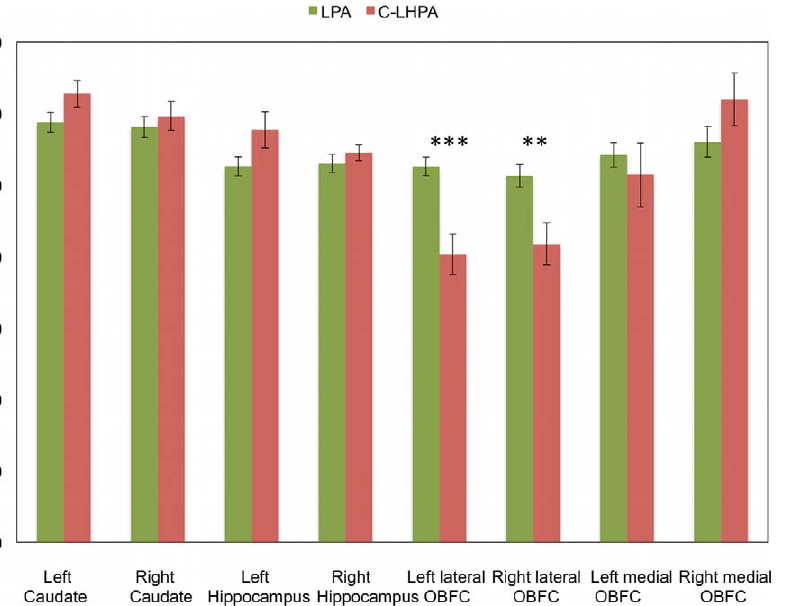
Figure 1. Normalized K* values, as a function of VOI and group. Values represents the mean 6 s.e.m. of the high vs . low physical aggression developmental trajectory) ( N =26). *** P , 0.001; ** P , 0.01.